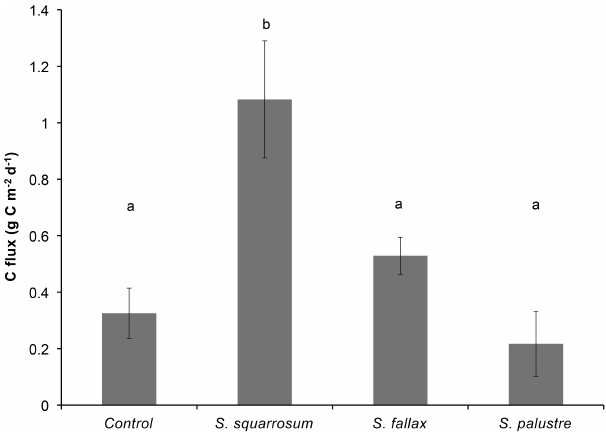
Figure 3. Daily net C (CO 2 + CH 4 ) fluxes ( ± SEM) for bare peat and peat covered with different Sphagnum vegetation, measured af- ter 6 weeks of experimental treatments. Since S. magellanicum only had a few living capitula left at this point in time, we excluded it from these measurements. Note that positive values represent net C emission to the atmosphere. Different letters indicate significant differences between the four species ( P =